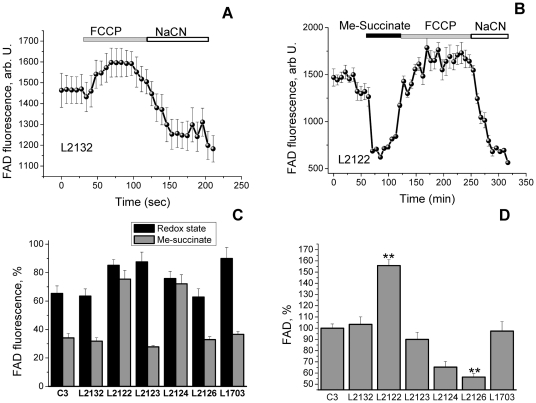
Level of FAD autofluorescence in fibroblasts with PINK1 mutations and control cells.Quantification of the %age change in FAD++ fluorescence: 100 is response to FCCP and 0% is response to cyanide, averaged traces for control L2132 and fibroblasts with PINK1 mutation L2122 presented in A–B. C-Fibroblasts with PINK1 mutations have increased FAD++ fluorescence than controls. This can be reversed by application of 5 mM Me-succinate to PINK1 mutated cells. D- Values of mitochondrial FAD autofluorescence.